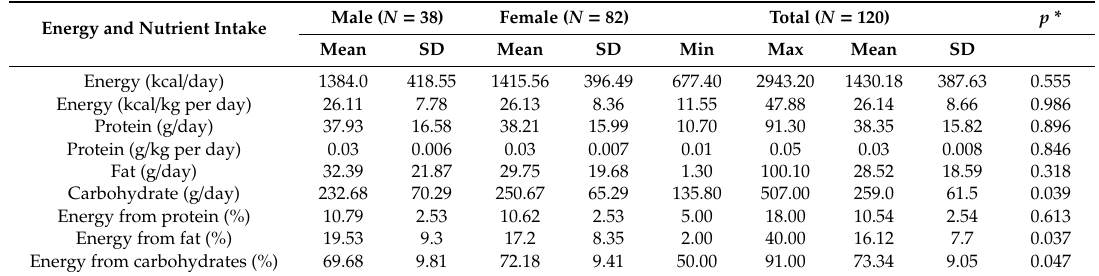
Table 5. Energy, macronutrient and water consumption of the study